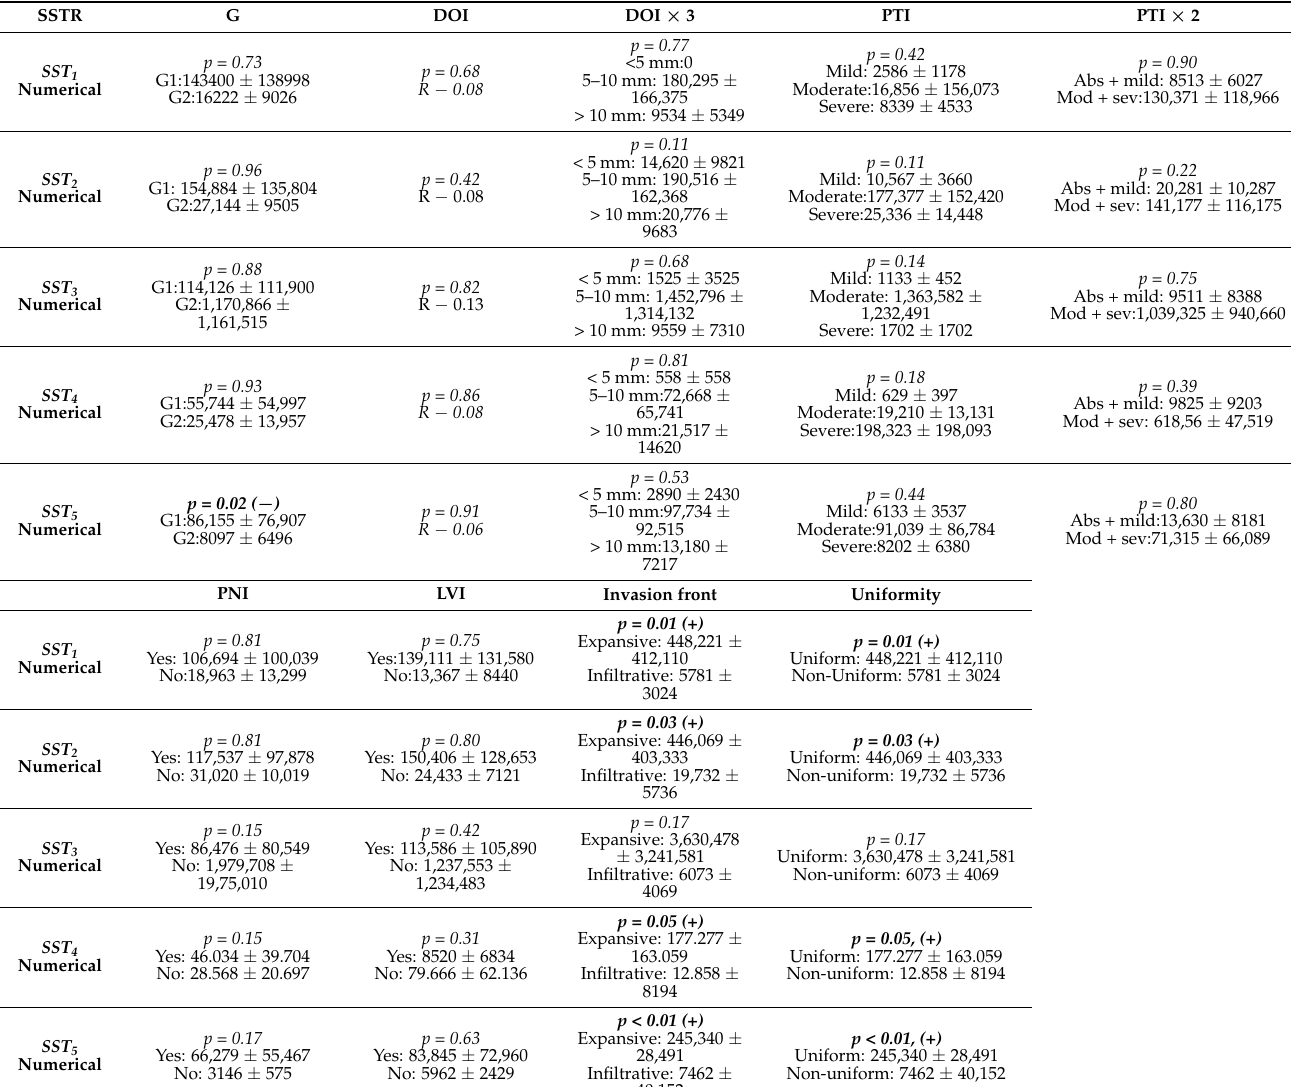
Table 4. In vivo relationship between SST-subtypes expression in OSCC and histopathological factors. SSTs numerical expression is expressed as mean ± SD in each category. Spearman test and Nonparametric Kruskal-Wallis and U-Mann Whitney tests are used to analyze the relationship between SSTs expression and histopathological